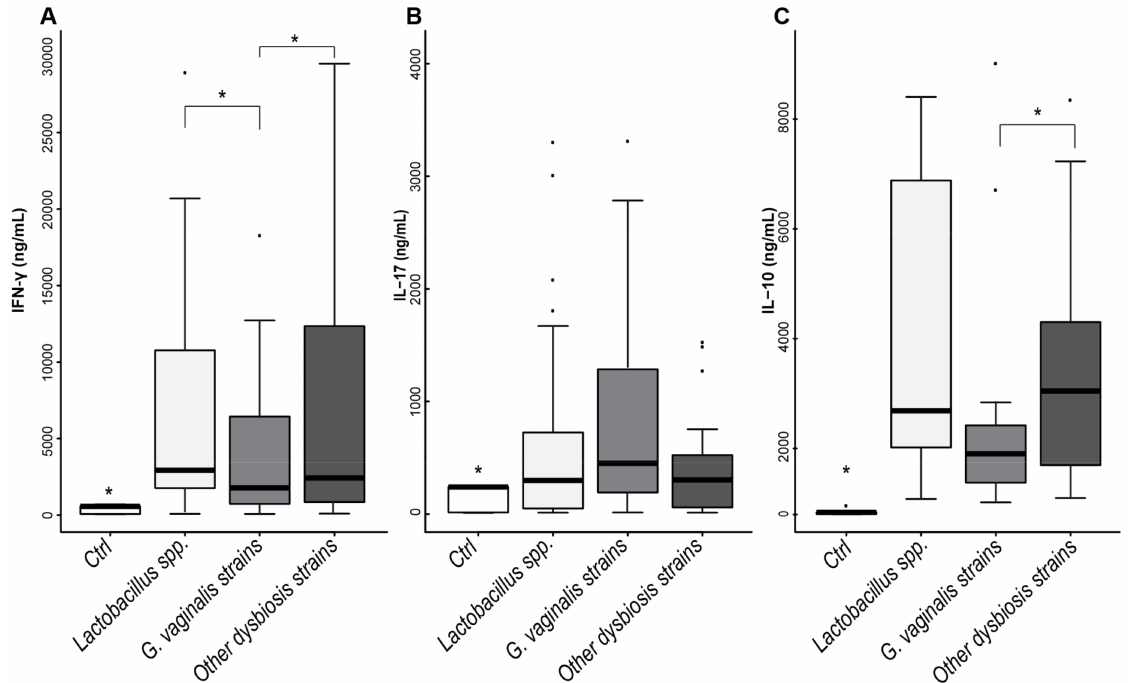
Figure 4. Cytokine production induced by lactobacilli or vaginal dysbiosis bacteria. Pooled bacterial lysates obtained by (1) Lactobacillus strains ( L. crispatus , L. jensenii , L. gasseri and L. iners ), (2) G. vaginalis strains (315-A, 49145, 14019 and 14018); (3) others vaginal dysbiosis bacteria ( A. vaginae , M. micronuciformis , P. bivia DNF-188 and P. bivia DNF-650) were used as a stimulus for PBMCs ( n = 9). ( A ) IFN- γ , ( B ) IL-17 and ( C ) IL-10 concentration was measured in culture supernatants of bacterial-stimulated cultures. The bar graph shows the median, and the whisker is calculated on the formula IQR × 1.5. Statistical analysis was performed by Kruskal–Wallis test, * p ≤ 0.01. Bonferroni p-value adjustment was used for IFN- γ and IL-10. Steel p-value adjustment was used for IL-17. Student t-test paired was used for IFN- γ and IL-10, p <